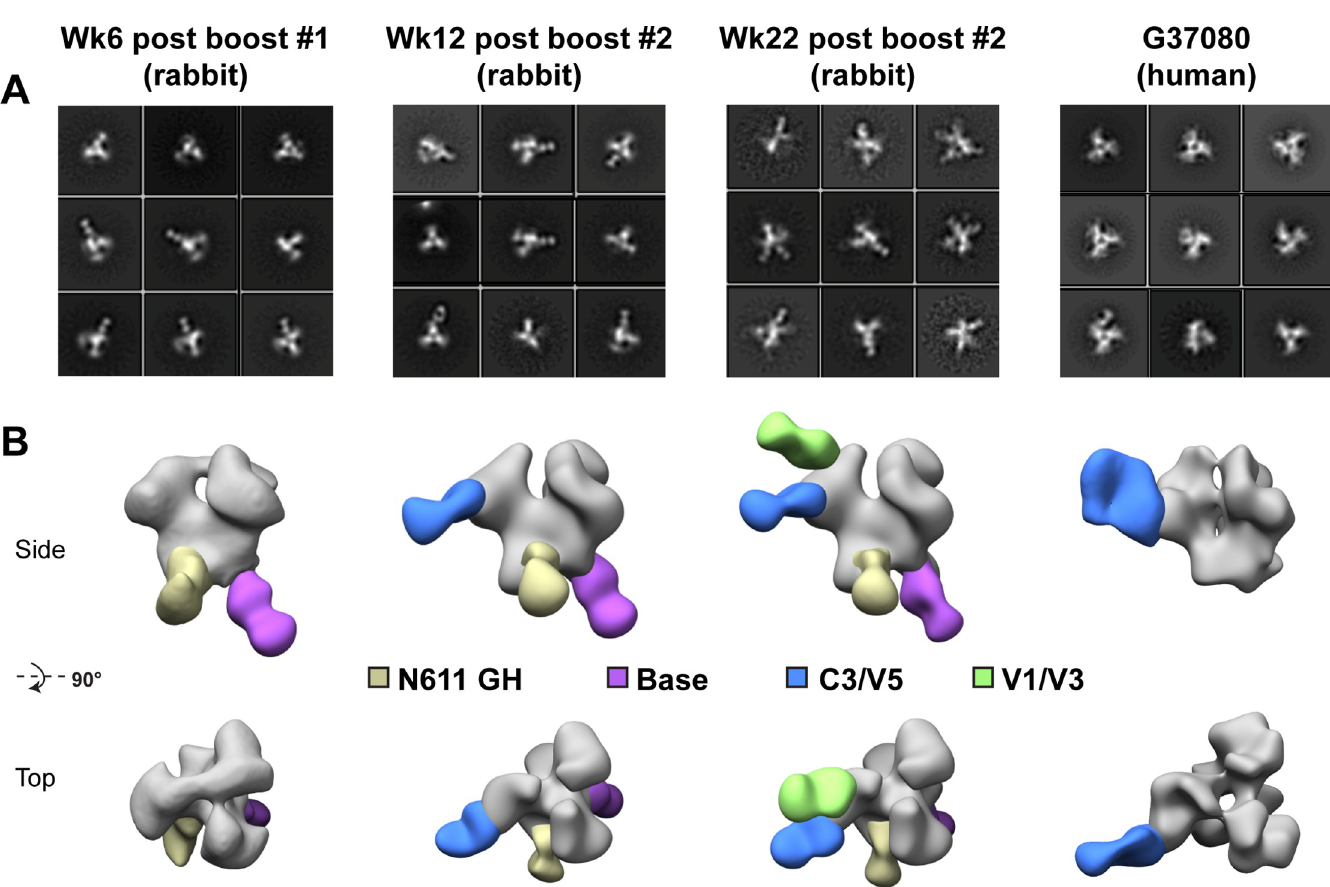
Fig 8. Mapping rabbit and human polyclonal antibody specificities by ns-EMPEM. A . Select 2D class averages and B. 3D reconstructions of 1PGE-THIVC SOSIP in complex with polyclonal rabbit IgG Fab following 3 different immunization time points or polyclonal human IgG from elite neutralizer donor G37080. For clarity, maps have been segmented into trimer (gray) and Fab (colored by epitope), and only one Fab per epitope is shown on each trimer. N611 GH = glycan hole due to sub occupancy; C3/V4/V5 and V1/V3 refer to gp120 constant and variable